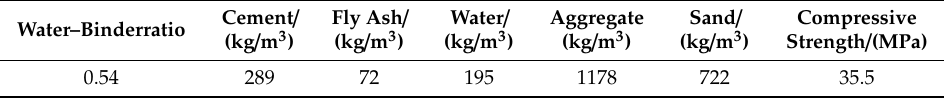
Table 3. Mix proportion and compressive strength of concrete.